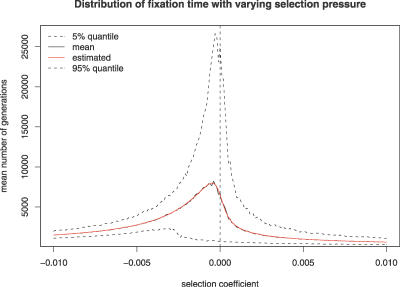
Validation of Trajectory LengthsMean, 5%, and 95% quantile of the length of trajectories of a mutant under different selection pressure. The mutant starts at allele frequency 0.1, evolves backward in time in a constant population with size N = 5,000, and is subjected to constant selection pressure with a selection coefficient s of −0.001 to 0.001, until it is lost or fixed. The red smooth curve represents theoretical estimates of the mean number of generations before this mutant is lost or fixed. Note that the simulated trajectories that are fixed or have more than one mutant at generation 1 are also accepted, in accordance with the theoretical estimates.